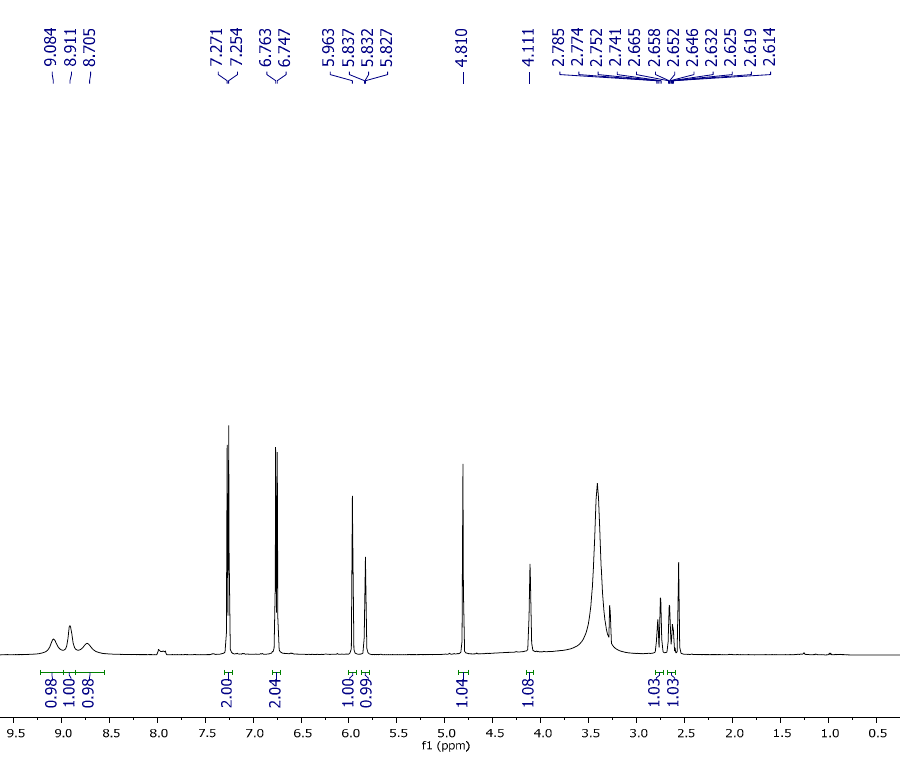
Figure 3. 1 H NMR of the CFL-1 (Epiafzelechin) fraction of C. fistula leaves.